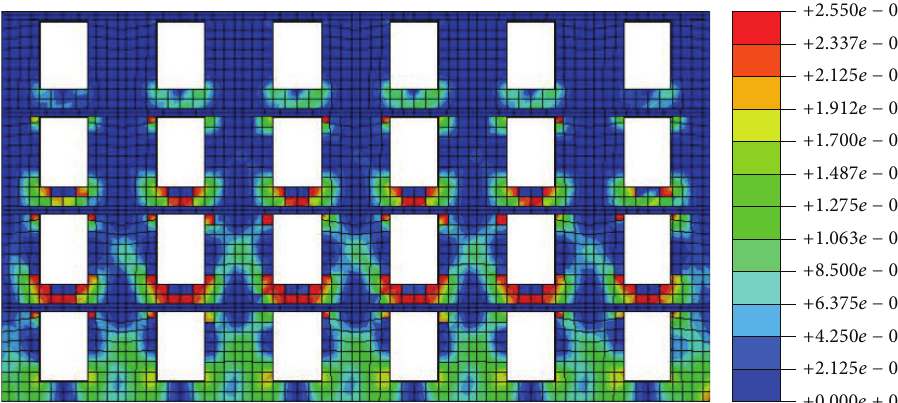
Figure 17: Tension crack damage cloud of model 6 under Lixian County ground motion.